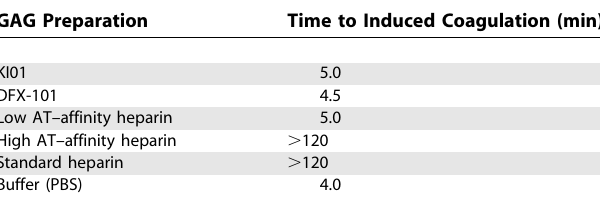
Table 1. Anticoagulant Activity of Different GAG-Preparations Measured with APTT Test